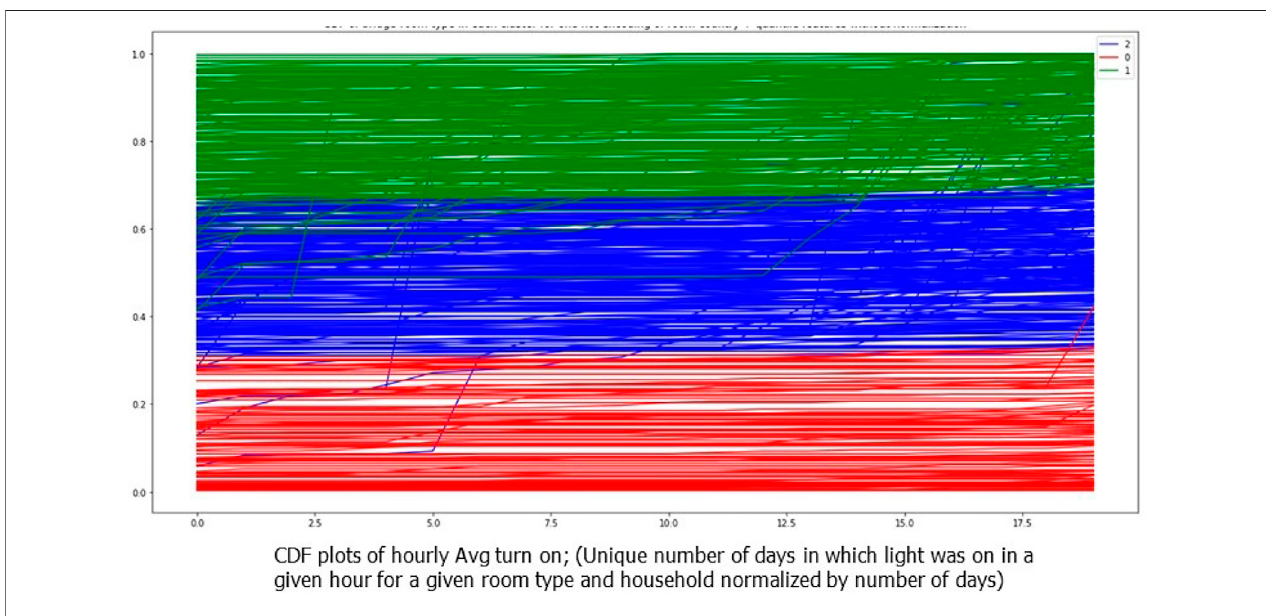
FIGURE 4 | CDF plots for each household-room type colored by cluster number.